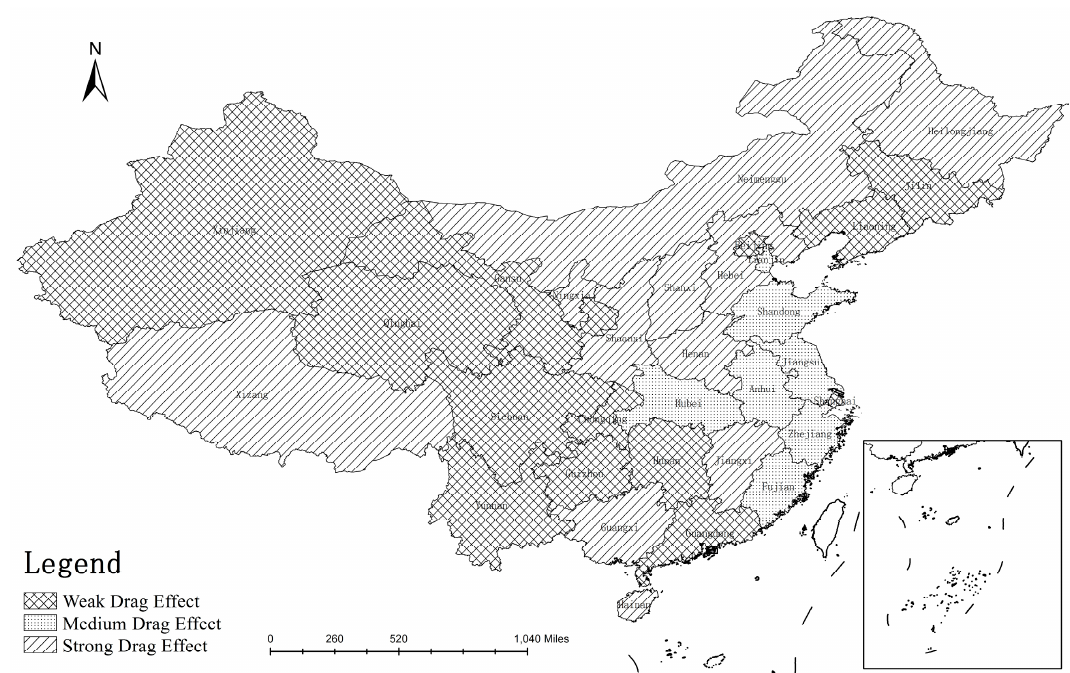
Figure 2. Water resources drag effect level for China’s 31 provinces.